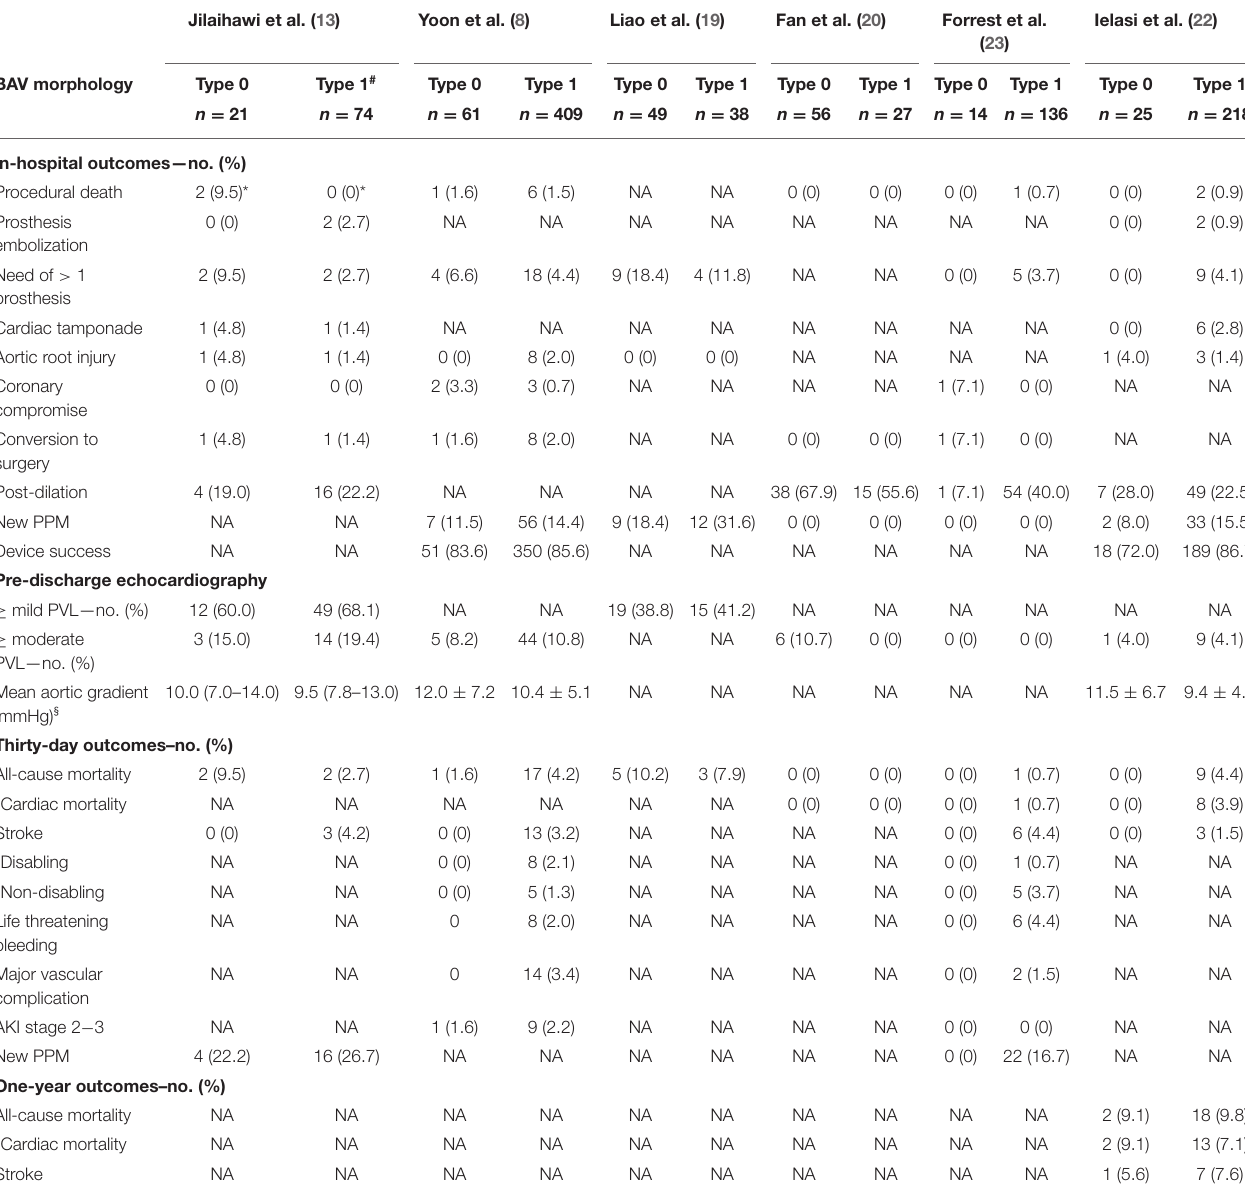
TABLE 6 | In-hospital and 30-day outcomes. Jilaihawi et al. (13) Yoon et al. (8) Liao et al. (19) Fan et al. (20) Forrest et al.